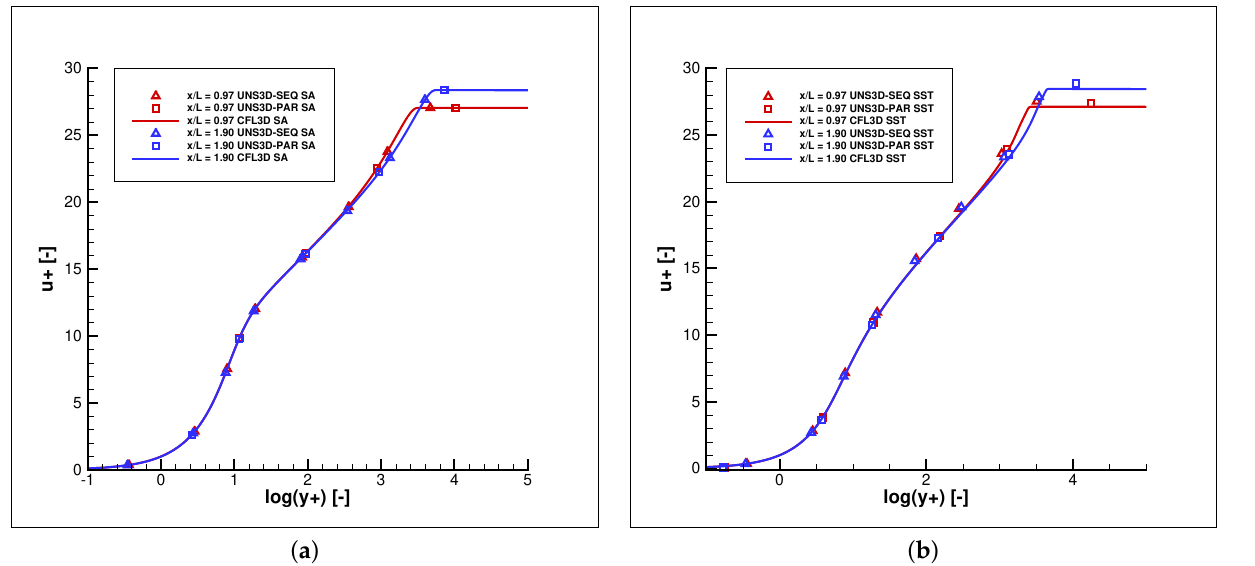
Figure 7. Law of the wake: ( a ) Spalart–Allmaras, and ( b ) Shear Stress Transport. Figure 8 shows the skin friction coefficients predicted using the Spalart–Allmaras and Shear Stress Transport models. For the Spalart–Allmaras model, the skin friction coefficient was calculated using UNS3D-SEQ, UNS3D-PAR, and FUN3D codes. The agree- ment among the results generated by these three codes was excellent. For the Shear Stress Transport model, the skin friction coefficient was calculated using UNS3D-SEQ, UNS3D-PAR, and FUN3D codes. The skin friction coefficient predicted by the UNS3D-SEQ code was slightly smaller than the results predicted by the other two codes. Most likely, this difference is due to the fact that UNS3D-SEQ used a coarser grid than the other two codes, as shown in Table